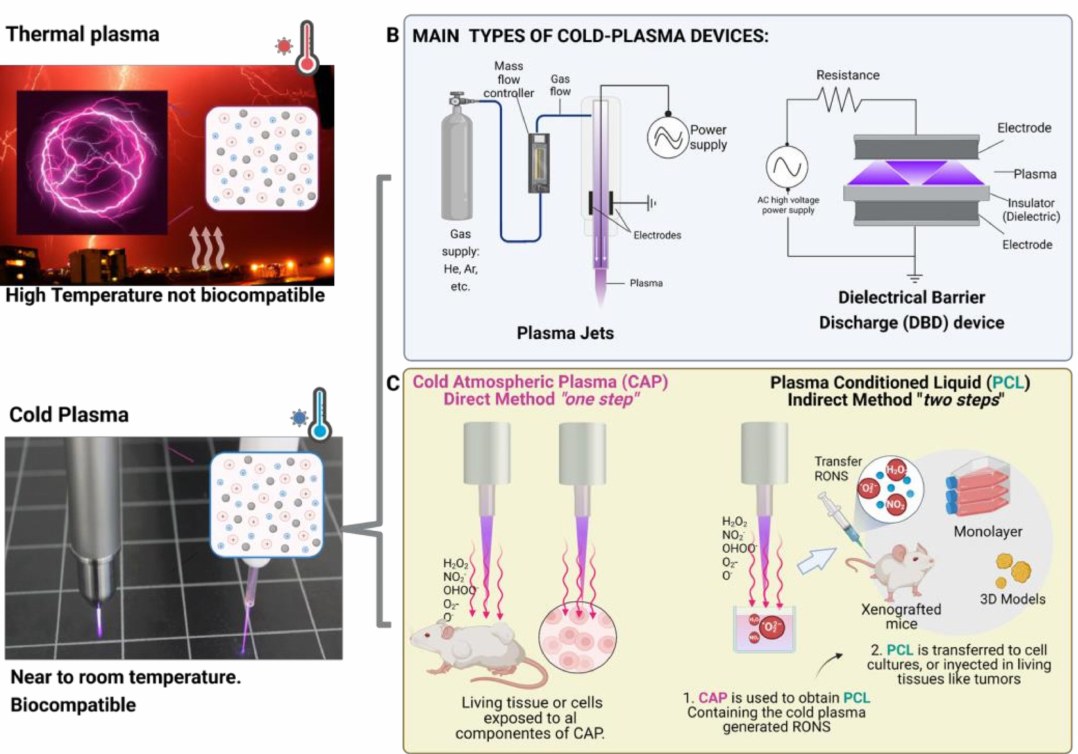
Figure 1. Overview of cold atmospheric plasma. ( A ) Atmospheric plasma can be divided into two categories: thermal plasma, which operates at nonbiocompatible temperatures (e.g., lighting), and cold atmospheric plasma (CAP), which operates near room temperature and is therefore suitable for biomedical applications. ( B ) There are two main types of CAP devices used in cancer research: plasma jets and dielectric barrier discharge. ( C ) These devices can be applied to tissues or cell cultures in two ways: directly, named as CAP; where all the components of the plasma act against the tissue or cells (left), or indirectly, where a plasma-conditioned liquid (PCL) containing the main cytotoxic components of the CAP (plasma-generated reactive oxygen and nitrogen species, or RONS) is obtained and applied to the tissue or cells (right). Figure created using